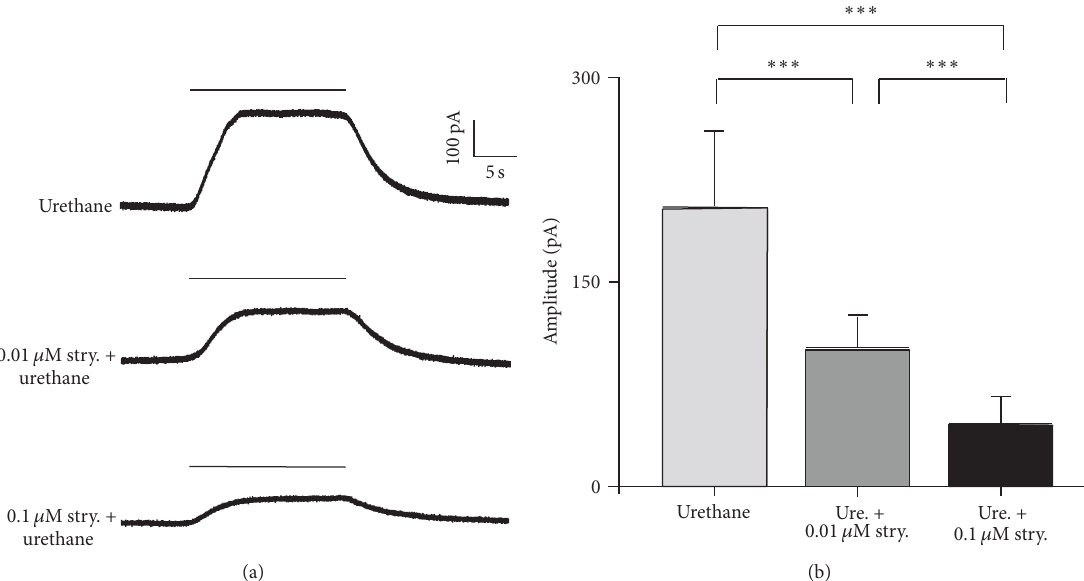
Figure 4: Urethane induces membrane current changes via the nicotinic AChR. (a) Strychnine, an antagonist of 𝛼 9 AChRs, partially blocked the OHC response to urethane. The cell was held at 0 mV, and 100mM urethane was pressure-ejected near the cell (timing denoted by the horizontal bar) to obtain the control response (top trace). Either 0.01 (middle trace) or 0.1 𝜇 M strychnine (bottom trace) was coapplied with urethane to the OHC. The magnitude of the outward currents decreased as the coapplied strychnine concentration increased. A 3 min waiting period was used between each trial. (b) The average amplitudes of outward current in response to 100mM urethane or 100 mM urethane coapplied with two different doses of strychnine. Bar = SD. ∗∗∗ 𝑝 < 0.001 , Student’s 𝑡 -test. 𝑁 = 7